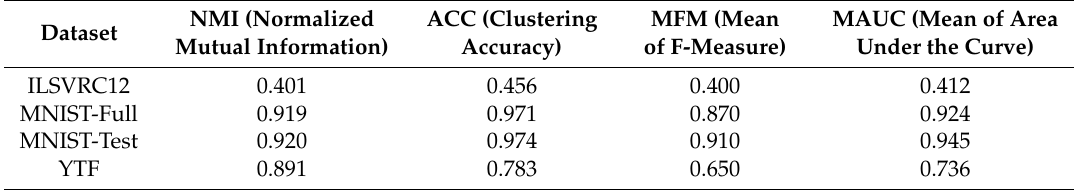
Table 3. Results of Performance Measures (NMI, Acc, MFM & AUC) of Proposed work (FRUCNN). Dataset